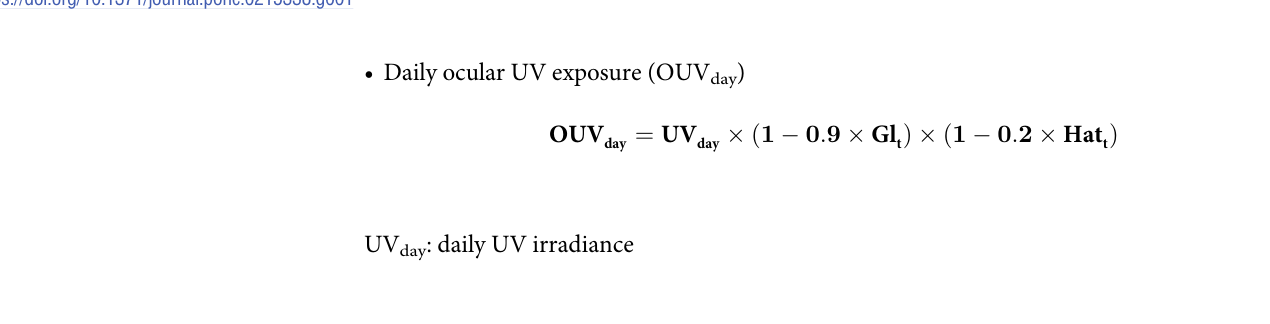
Fig 1. Kanazawa Medical University Cataract Classification and Grading System. a: Retrodots—Judged by size of area of opacity within the central 3-mm diameter area of the pupil, b: Waterclefts—Central type WC: opacity inside but not outside the central 3-mm diameter area of the pupil, Peripheral type WC: opacity outside but not inside this central 3-mm diameter